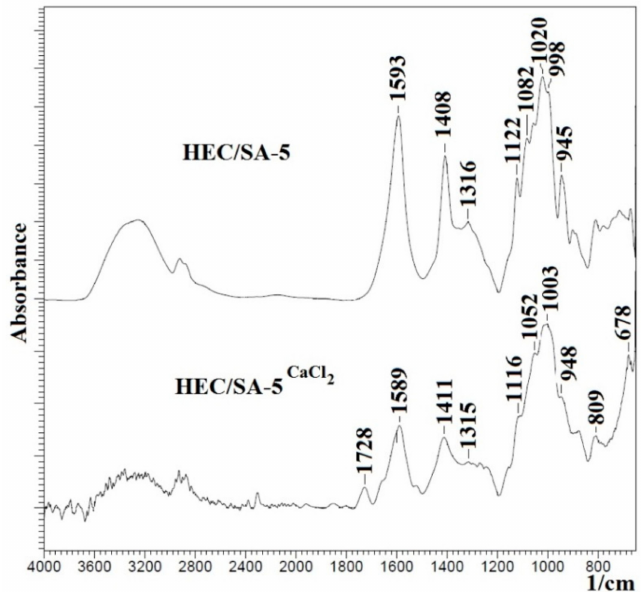
Figure 4. The FTIR spectra for HEC/SA-5 and cross-linked HEC/SA-5 CaCl2 membranes.